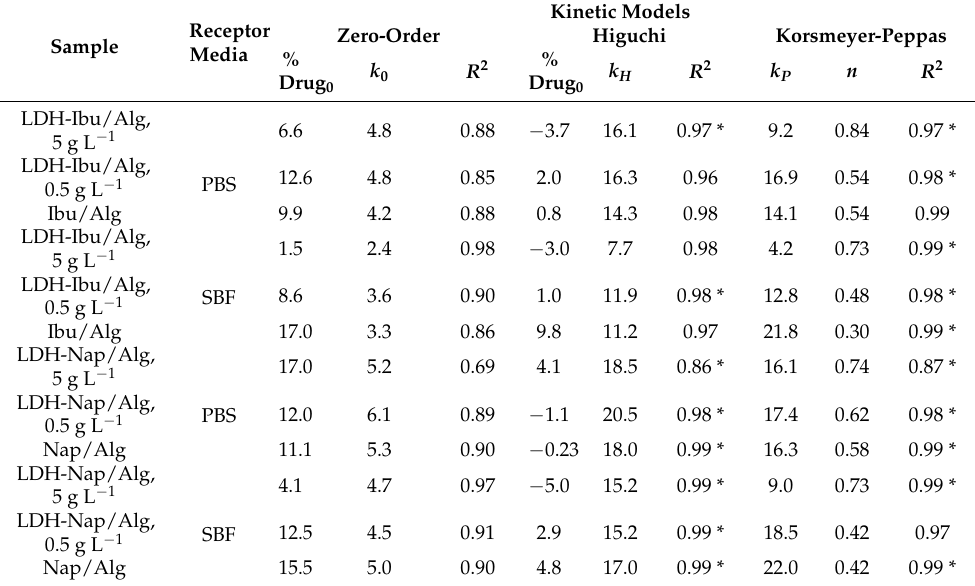
Table 2. Release kinetic data obtained from drug release studies using empirical equations: zero-order, Higuchi and K-P models, fittings with the best R 2 are marked with